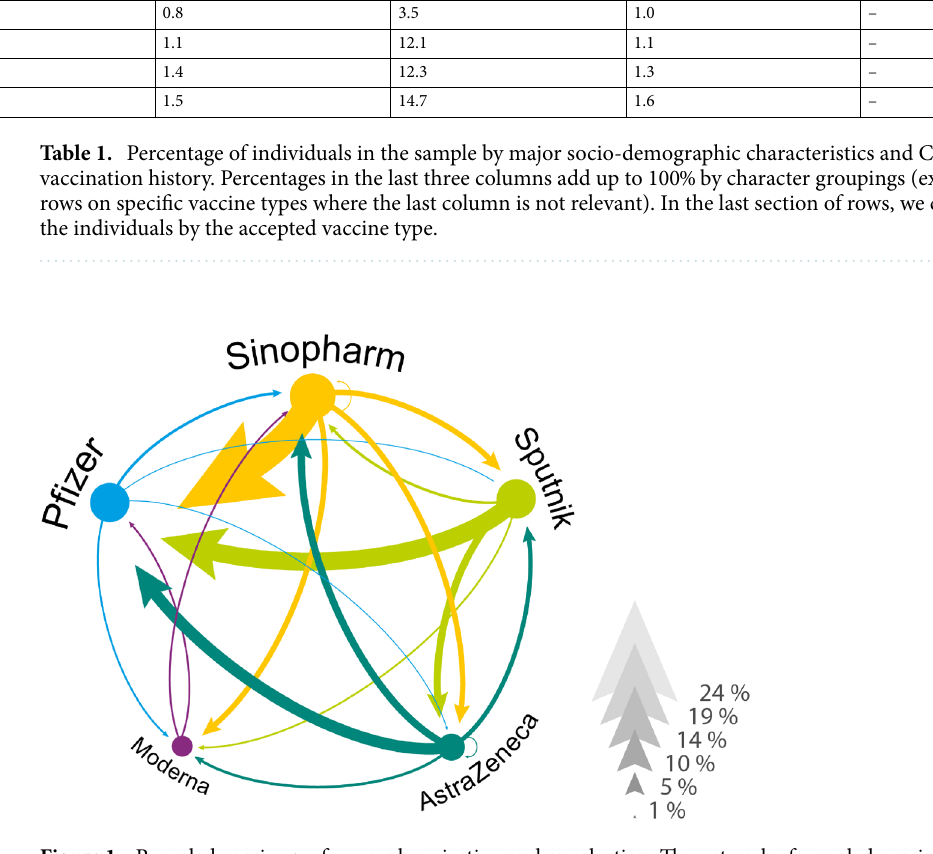
Figure 1. Revealed vaccine preferences by rejection and re-selection. The network of revealed vaccine preferences in Hungary. Vaccines are linked if someone in our data has rejected one vaccine and later accepted another. The direction of the link goes from rejected to accepted and the width of the arrow corresponds to the percentage of individuals who acted accordingly. We conditioned on those individuals who rejected at least one